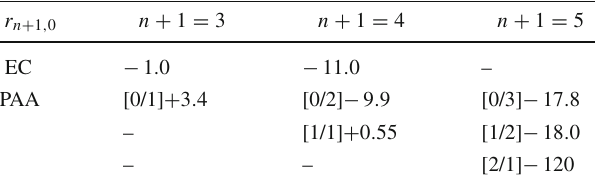
Table 1 Comparison of the exact (“EC”) ( n + 1 ) th-order conformal coefficients with the predicted (“ [ N / M ] -type PAA”) ( n + 1 ) th -order ones based on the known n th-order approximate R n ( Q = 31 . 6 GeV ) ,